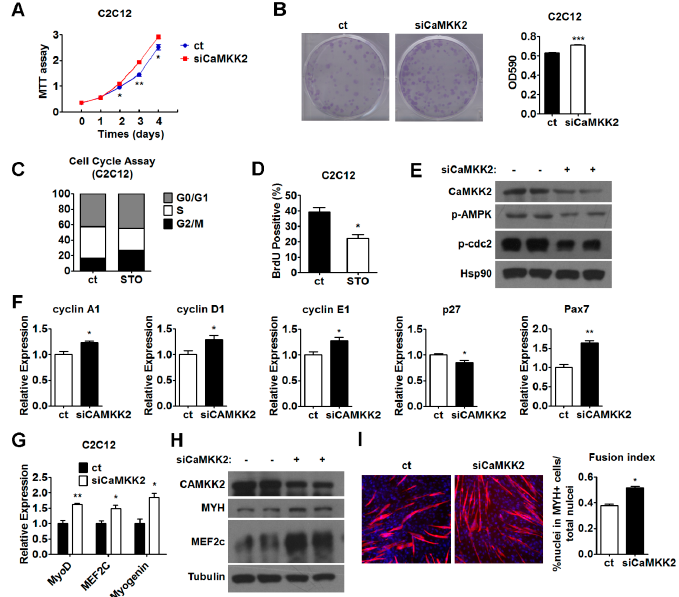
Figure 4. Down-regulation of CaMKK2 promotes C2C12 myoblasts proliferation and differentiation. ( A ) MTT assay of the proliferation of C2C12 myoblasts transfected with siCaMKK2 or control and maintained over a period of 5 days; ( B ) Representative micrographs of crystal violet-stained C2C12 cell colonies, which were transfected with siCaMKK2 as indicated ( left ), absorbance of each well at 590 nm ( right ) ( n = 3); ( C ) Flow cytometric analysis of the C2C12 myoblasts treated with 10 μ M STO-609 during proliferation. Percentage of cells in G1, S and G2 phases were analyzed ( n = 3); ( D ) DNA synthesis in C2C12 cell treated with 10 μ M STO-609 by BrdU incorporation assay. Quantification of the BrdU positive cells ( n = 3); ( E ) Representative western blot showing the p-cdc2 Tyr15 protein level in C2C12 cells transfected with siCaMKK2; ( F ) Quantitative RT-PCR analysis of cyclin A1, cyclin D1, cyclin E1, p27 and Pax7 mRNA levels in the C2C12 myoblasts transfected with siCaMKK2 ( n = 3); ( G ) Quantitative RT-PCR analysis of MyoD, MEF2c and Myogenin mRNA levels in the C2C12 myotubes transfected with siCaMKK2 ( n = 3); ( H ) Representative western blot showing the MYH, MEF2c protein expression in C2C12 myotubes transfected with siCaMKK2; and ( I ) Immunofluorescence analysis of MYH was performed in C2C12 myotubes 48 h after siCaMKK2 transfection ( left ), quantification of the fusion index of indicated cells ( right ) ( n = 3). Experiments were repeated at least twice. Means ± SEM (error bars) are shown. *, p < 0.05; **, p < 0.01, ***, p < 0.001.